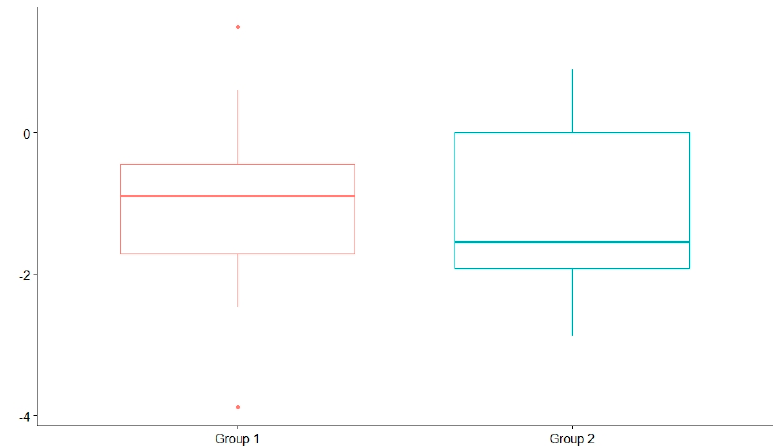
Figure 4. z-score eight comparison after 2 years on the diet; group 1: children older than 2 years, group 2: children younger than 2 years. 2: children younger than 2